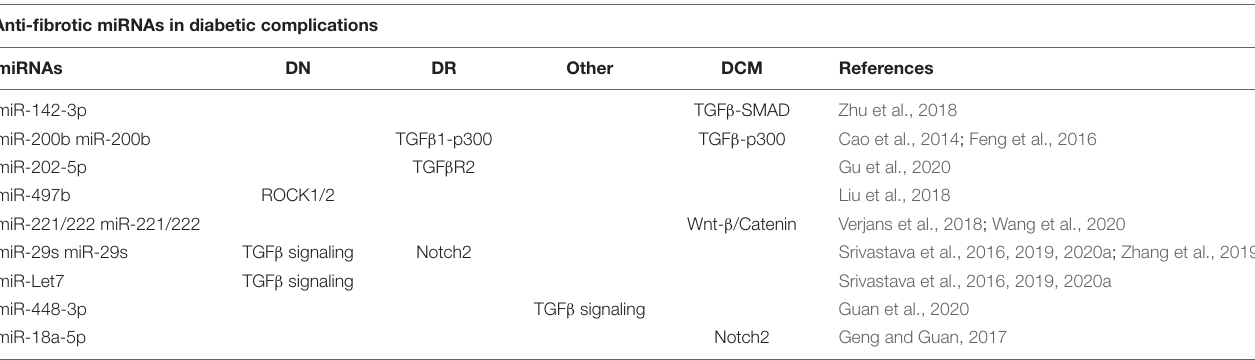
TABLE 1 | Anti-fibrotic miRNAs in diabetic